Question: Briefly state, in one sentence, what is plotted here.
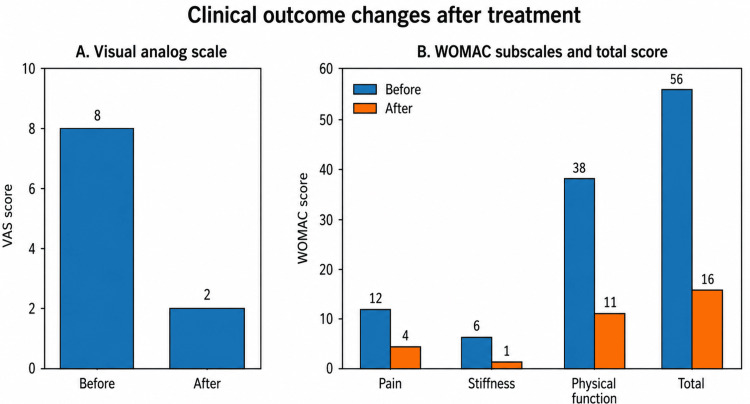
Answer: Clinical outcome changes from baseline to the latest clinical follow-up The VAS pain score decreased from 8 at baseline to 2 at the latest clinical follow-up. The WOMAC pain score improved from 12 to 4, stiffness from 6 to 1, physical function from 38 to 11, and total WOMAC score from 56 to 16. VAS: Visual analog scale, WOMAC: Western Ontario and McMaster Universities Osteoarthritis Index